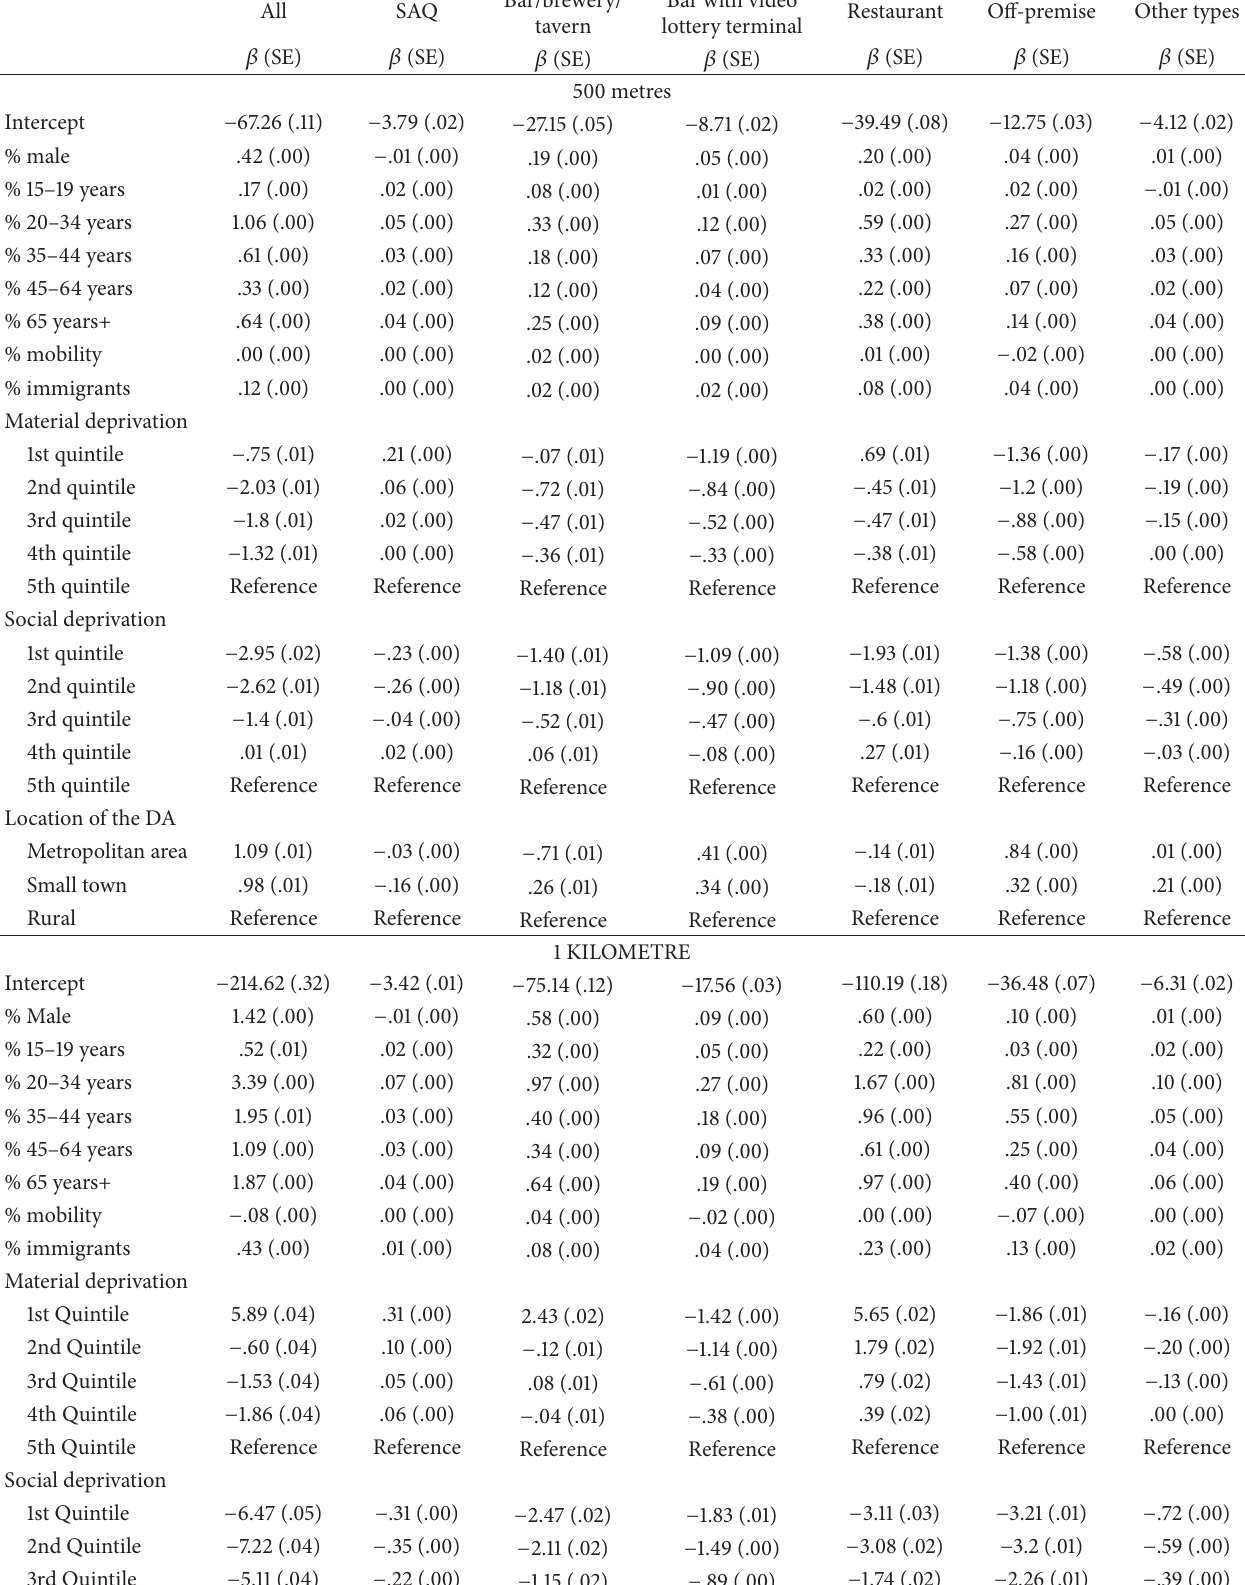
Table 2: Weighted Tobit results for neighborhood factors associated with the availability of alcohol outlets ∗